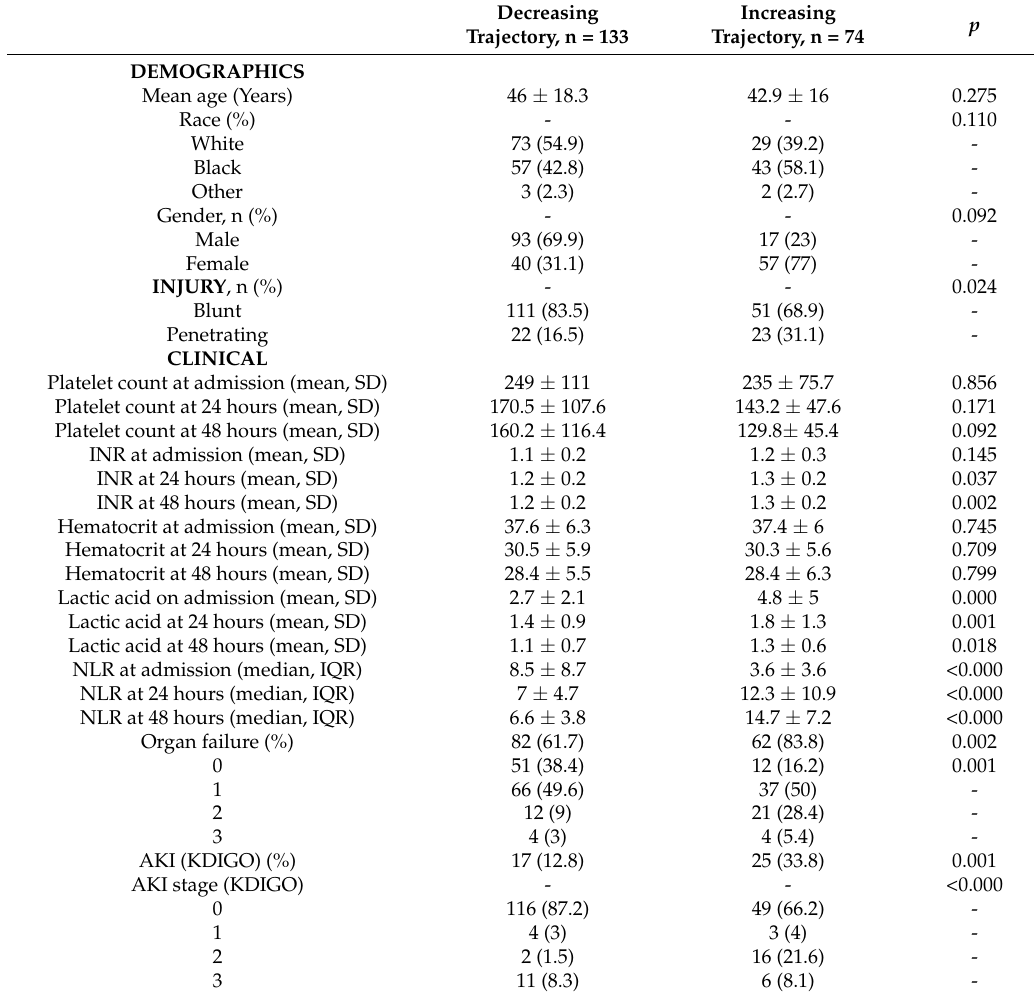
Table 1. Demographic, injury, and clinical characteristics of trauma patients admitted to the intensive care unit “ICU” in both